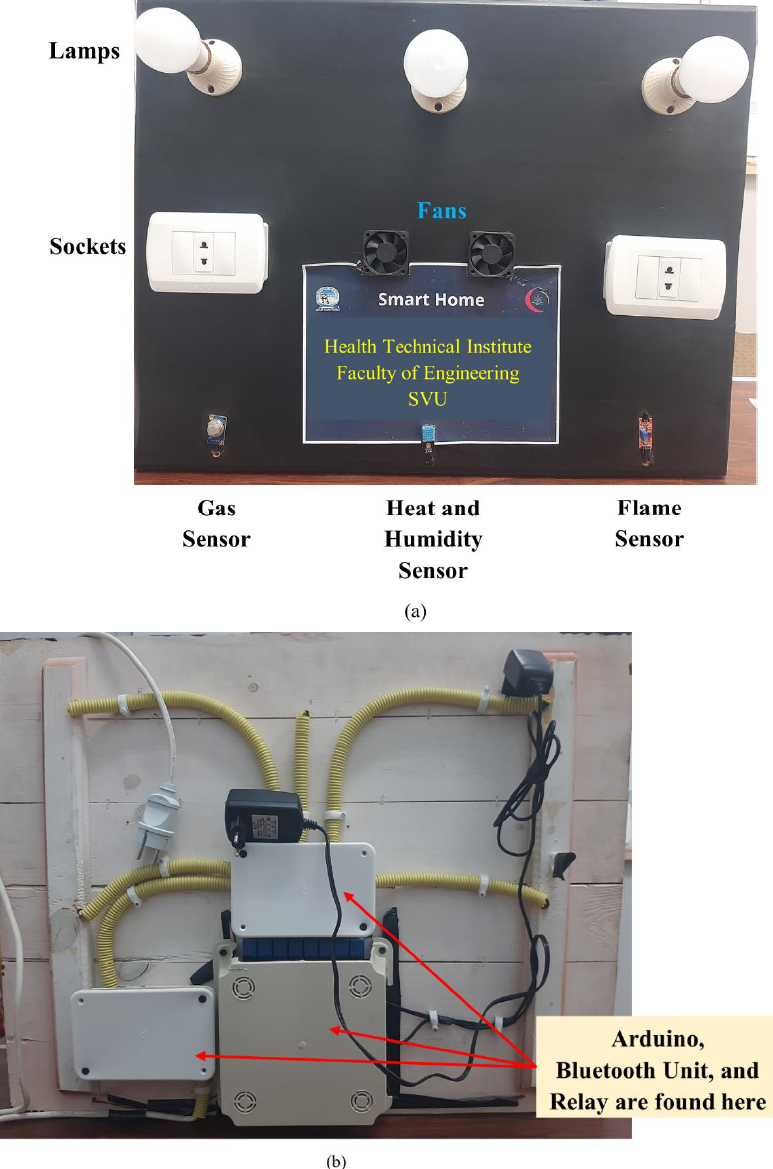
Figure 13. The simulation of the smart home: ( a ) All of the components (lamps, sockets, fans, and sensors) controlled by the five developed applications are arranged on the front side of the panel. ( b ) The connections, wires, Arduino unit, Bluetooth unit, and relay are configured on the back side of the